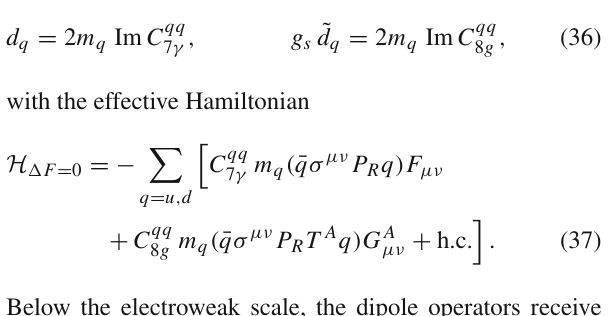
Fig. 2 Effective scales (cid:8) i of the Wilson coefficients C ( 1 ) qq for ε K (orange), D 0 - ¯ D 0 mixing (green) and the NP contribution to ε (cid:2) /ε (blue), parametrizedasin(25),(31),and(34),respectively.Theleftpanelshows the values in the “unhatted” basis where the down-type quark mass matrix is diagonal, the right panel in the “hatted” basis where the up-